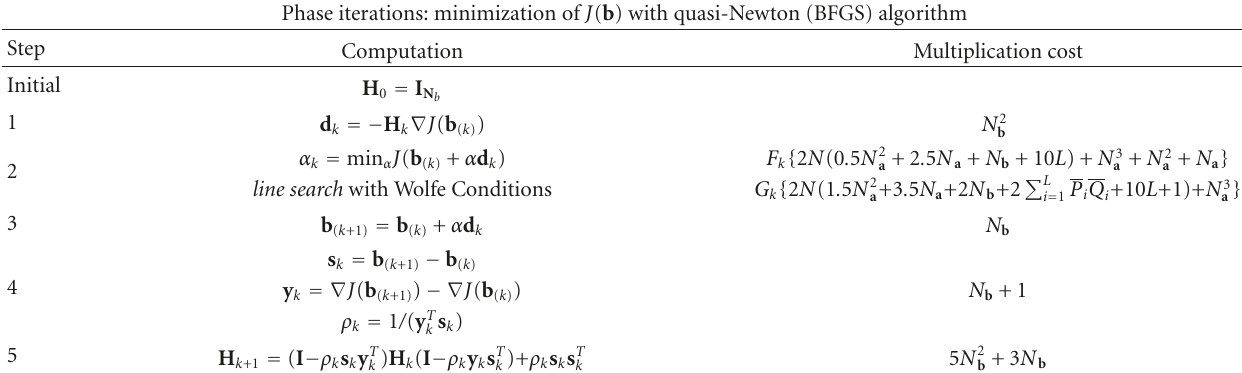
Table 2: Minimization of J ( b ) with quasi-Newton (BFGS) algorithm.